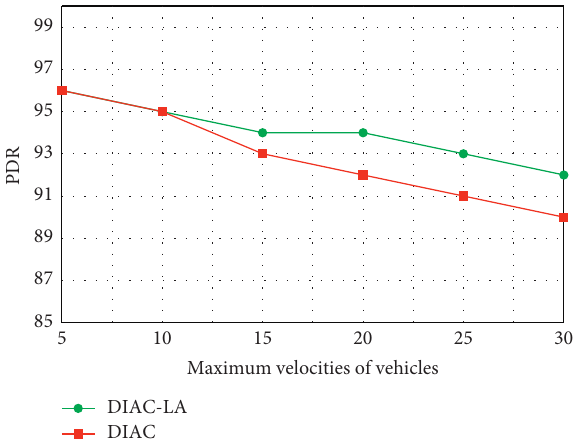
Figure 8: The difference in PDR at maximum velocities of vehicles.